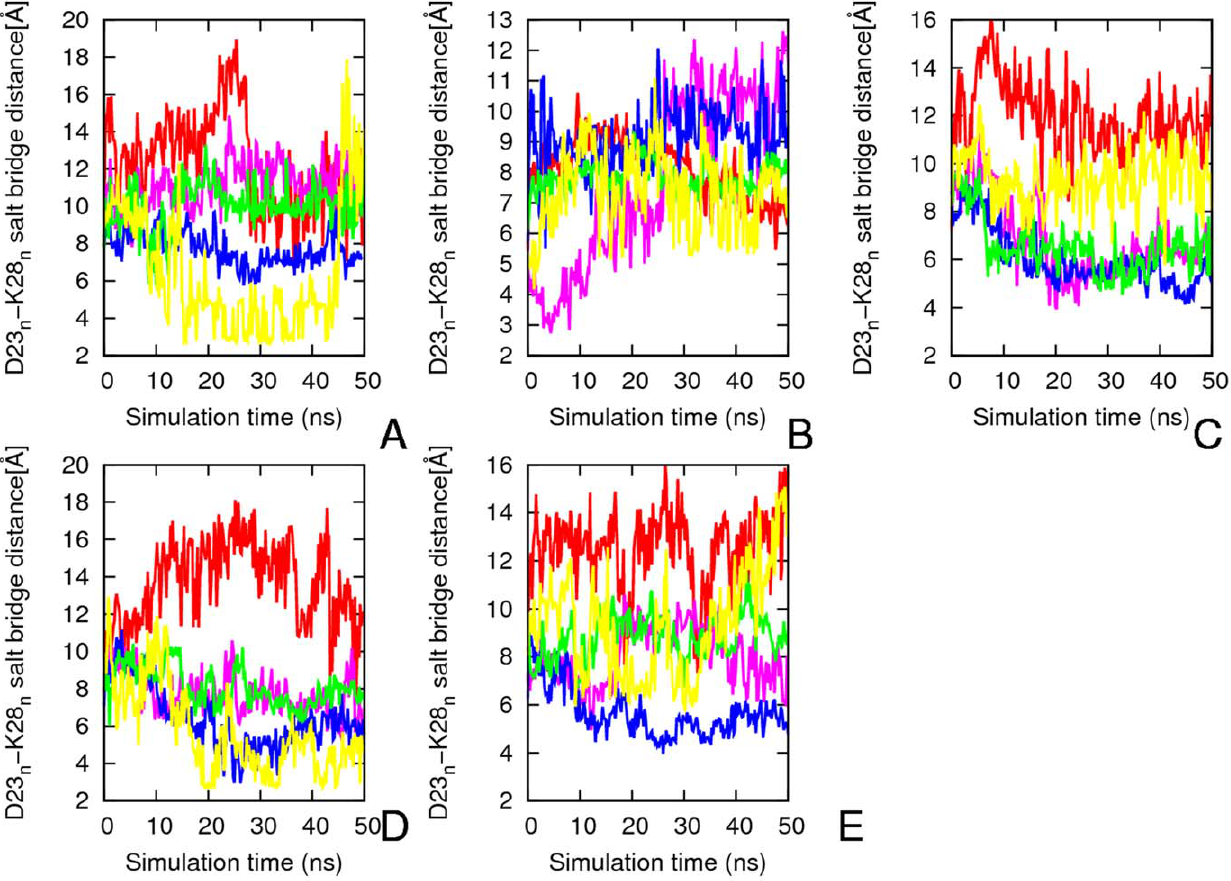
Figure 6. Average intra-chain salt bridge distance (Asp n23 /Lys n23 ) along the 50 ns simulation for A b segmental polymorphs. The results are the average of two independent simulations and it is the average of the two layers of each system. A) 16–21P B) 16–21AP C) 27–32 D) 35– 42 and E) 30–40. Red, 1 D 23 - 1 K 28 ; pink, 2 D 23 - 2 K 28 ; blue, 3 D 23 - 3 K 28 ; green , 4 D 23 - 4 K 28 ; yellow, 5 D 23 - 5 K 28 .